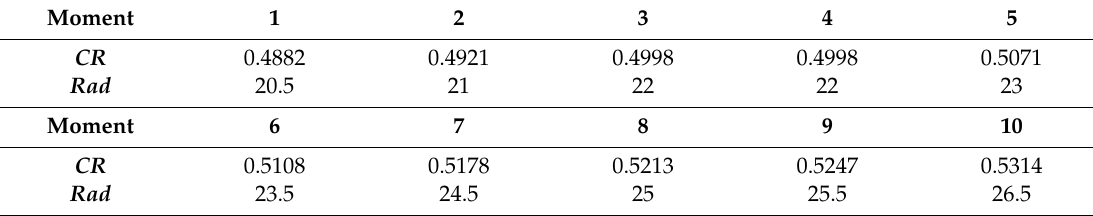
Table 5. The results calculated by the original model in a crossing encountering scenario.